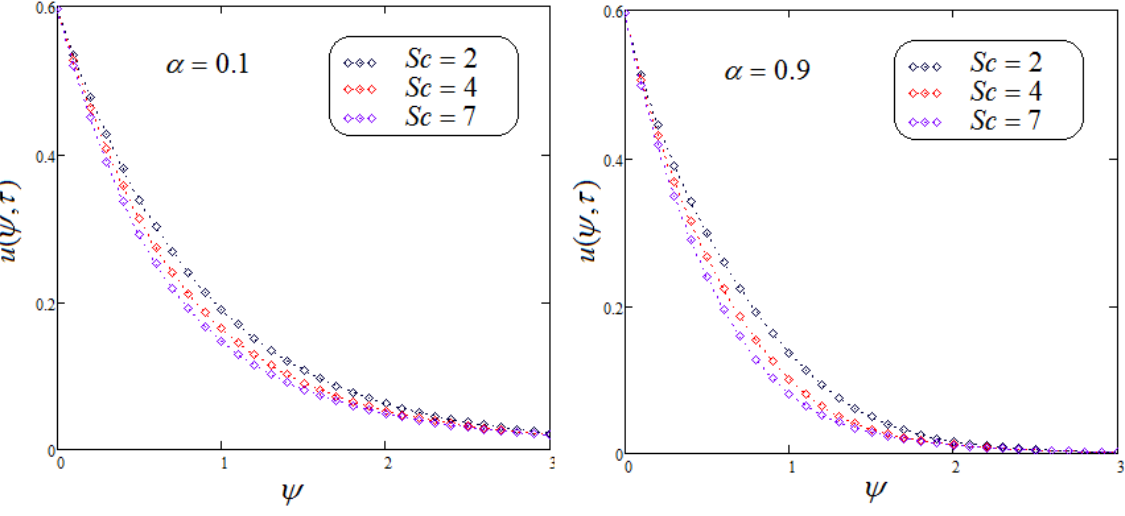
Figure 8. Trace of velocity for dissimilar values of Sc